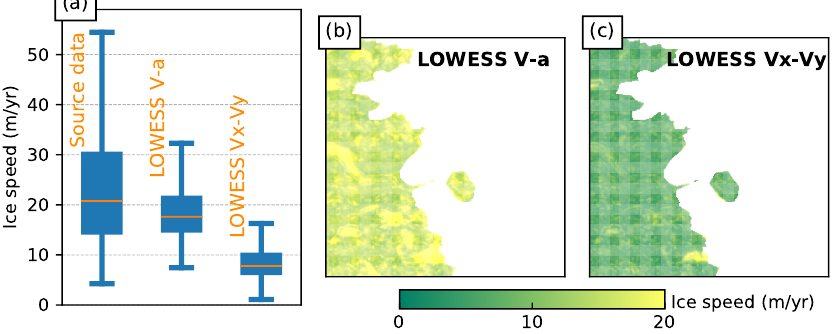
Figure 11. ( a ) Distribution of the average ice velocity for 2015–2019 on ice-free region for initial measurements and the LOWESS solutions using the components ( v , α ) or ( v x , v y ). ( b , c ) Maps of the average ice velocity on the ice-free region for the same time period from the LOWESS solutions using the components ( v , α ) or ( v x , v y ), respectively. Same spatial extent as for Figure 10 is